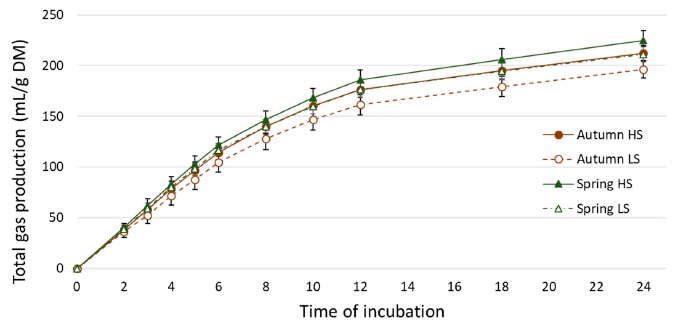
Figure 1. Total gas production throughout the 24 h of in vitro incubation. HS: high sugar pasture; LS: standard cultivar pasture. DM: dry matter.